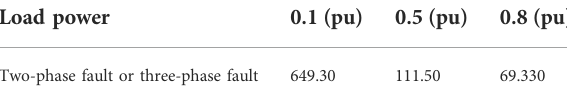
TABLE 3 R e ( Z ( ω f )) in case of instantaneous fault at overhead